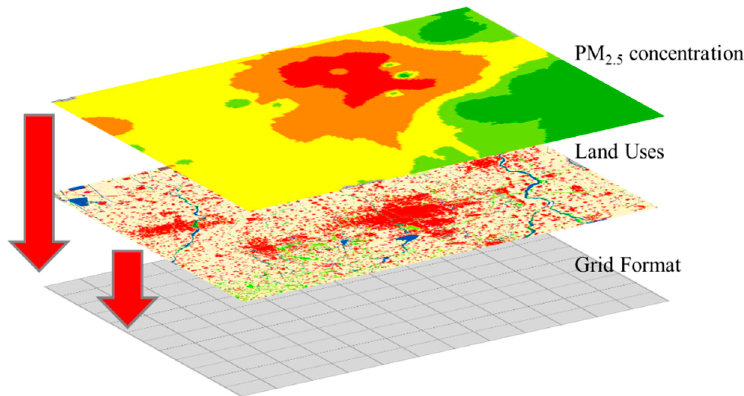
Figure 3. Data integration and grid structure.